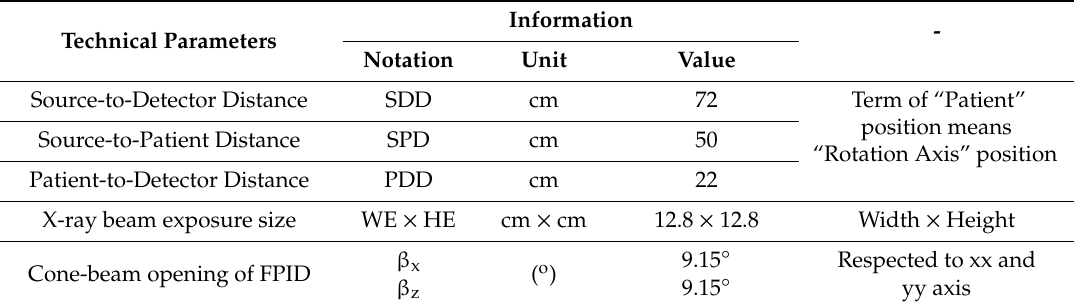
Table 1. DCT100-0X0 cone-beam computed tomography (CBCT) technical configuration. FPID: flat-panel imaging